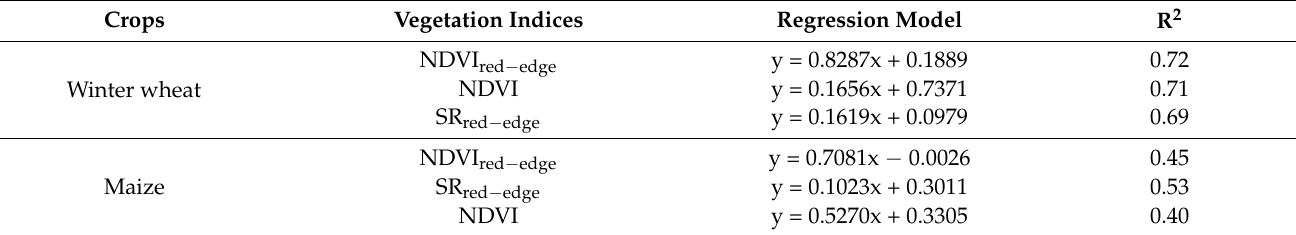
Table 3. Regression accuracy of the FPAR of the red-edge vegetation indices.